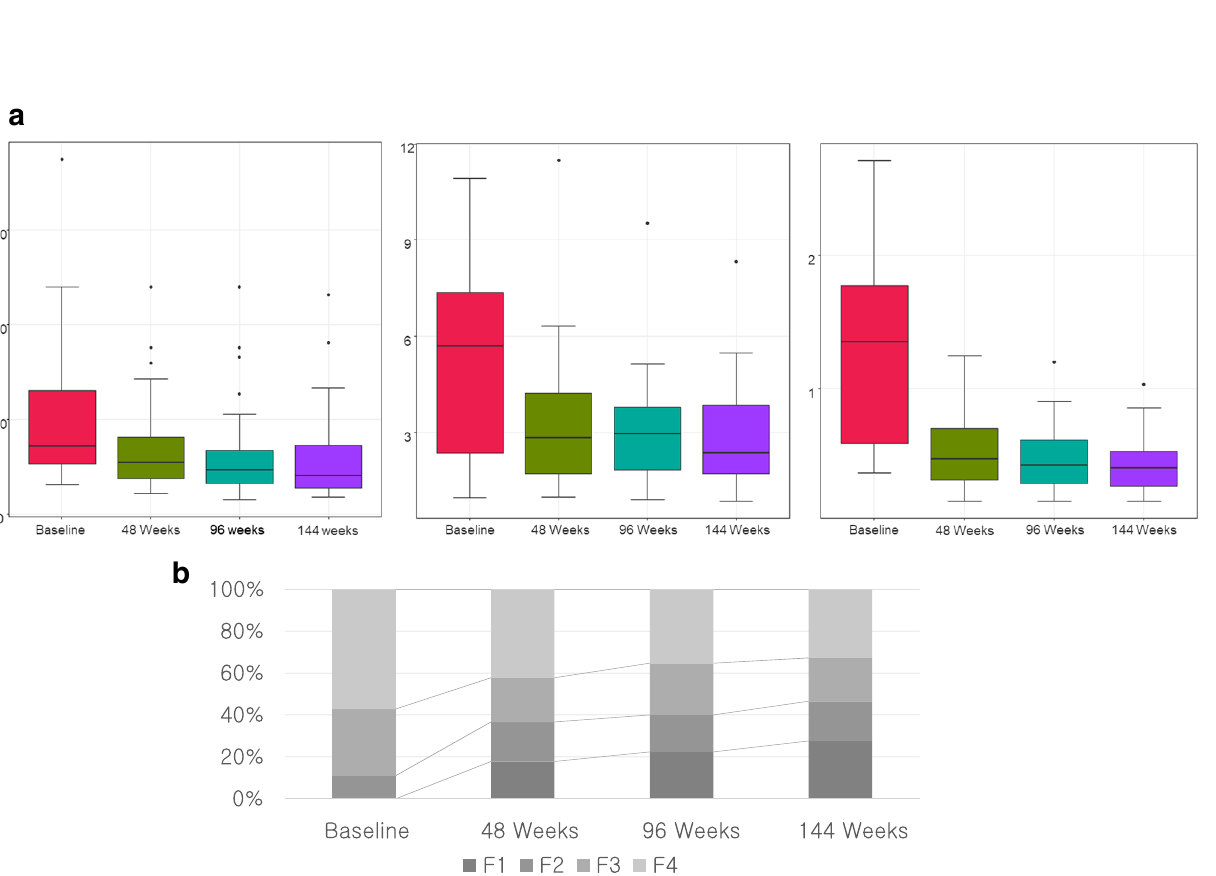
Figure 2. ( a ) Comparison of changes in liver stiffness, APRI, and FIB-4 index. ( b ) Distribution of fibrosis stage across different time